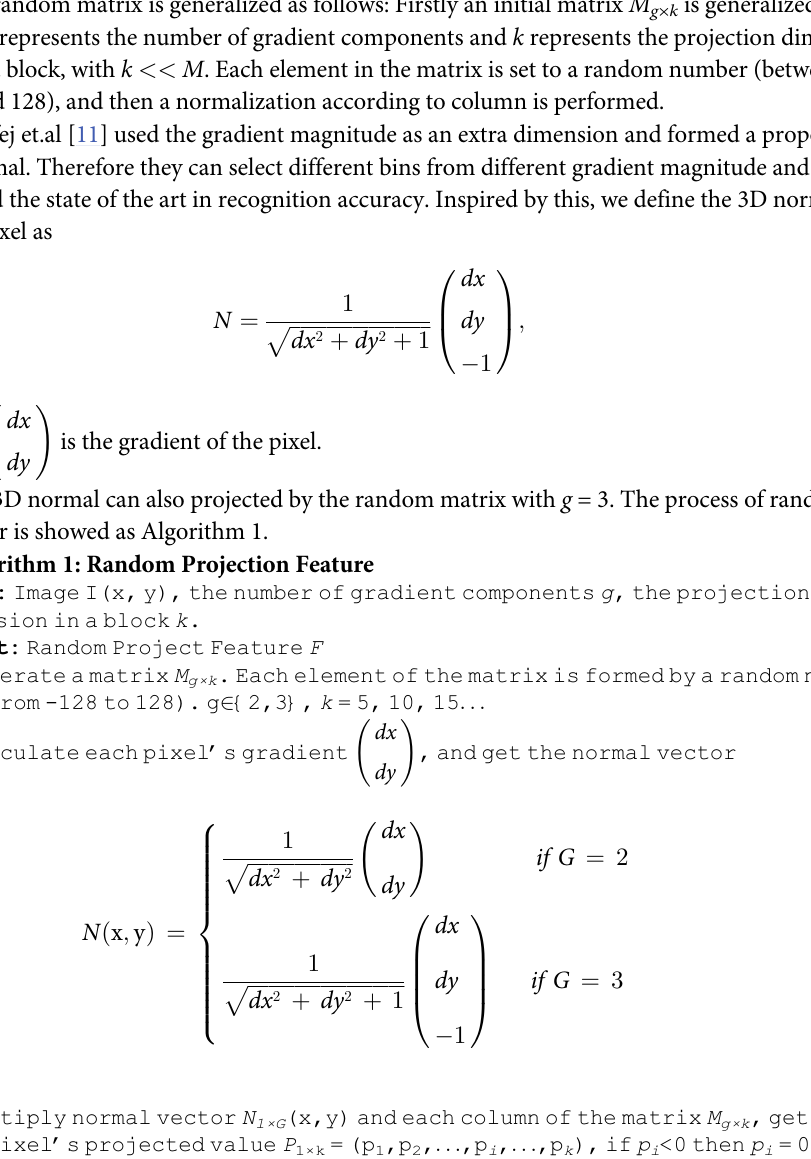
Algorithm 2: Random Integral Haar